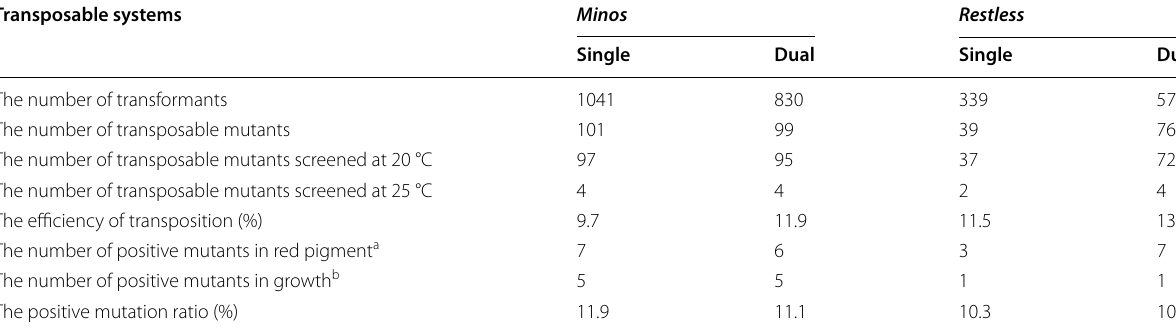
a The mutants with variation percentage over 10% in red pigment production were considered as positive mutants, including MPS1–MPS10 and MPD1–MPD13 b The mutants with variation percentage over 15% in cell growth were considered as positive mutants, including MPS1, MPS3, MPS4, MGS1, MGS3, MGS6, MPD1, MPD2, MPD4, MGD2, MGD4, and MGD6